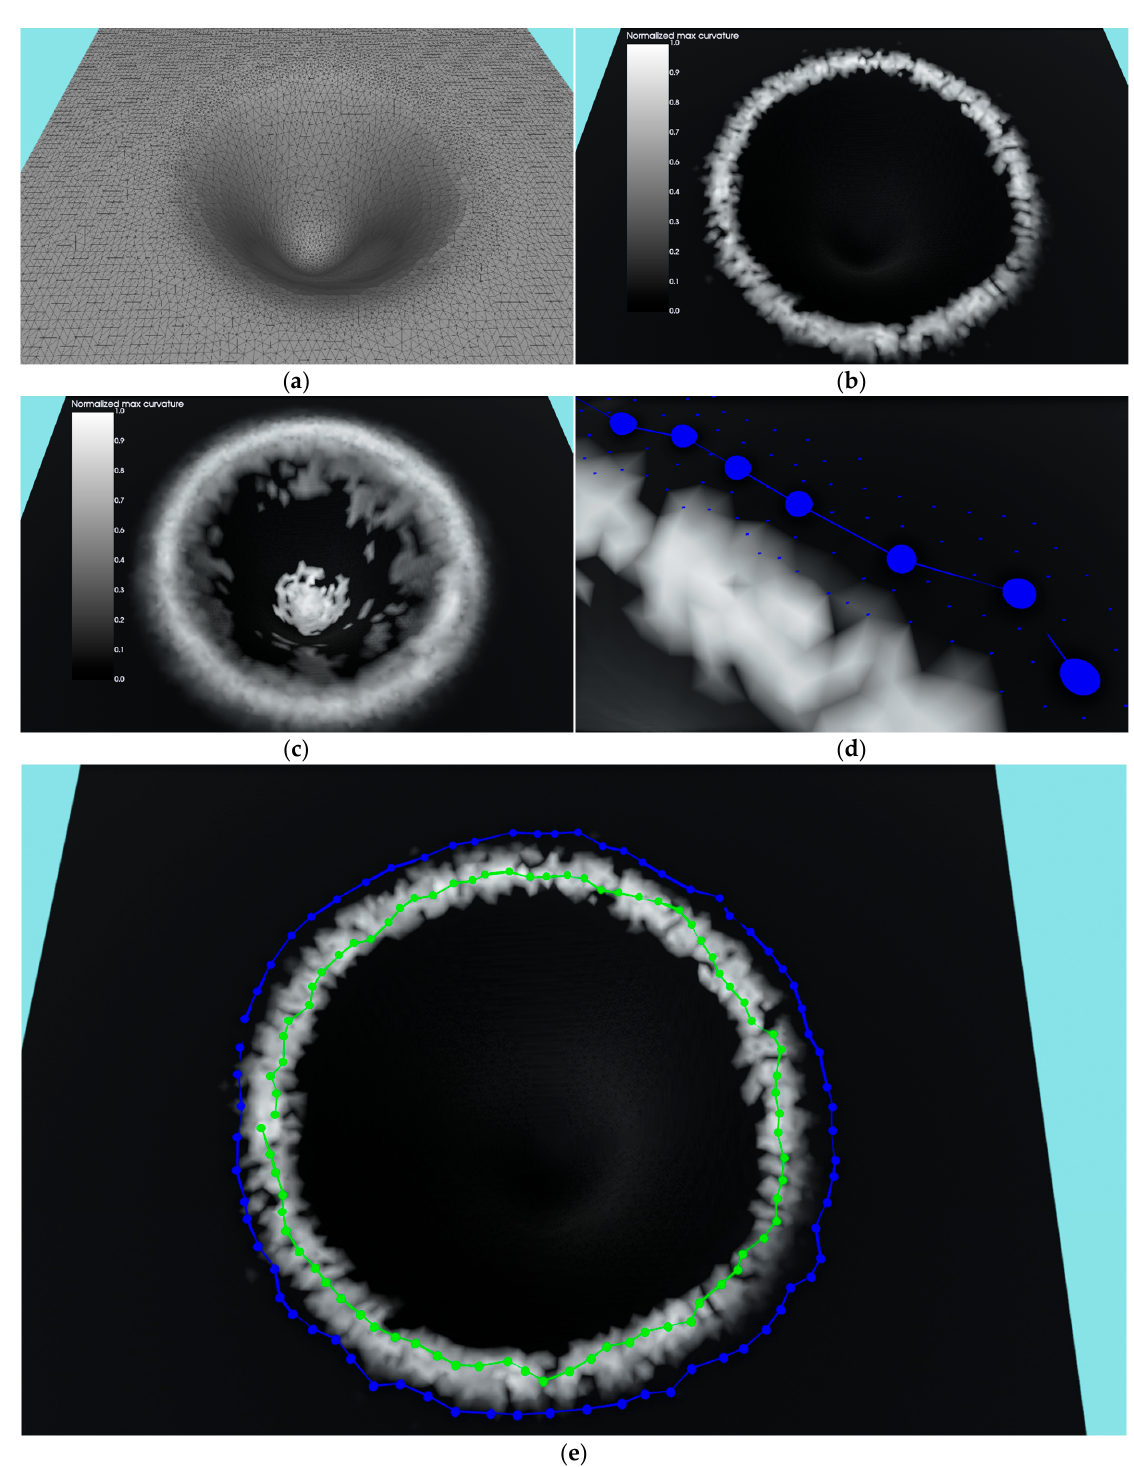
Figure 13. Synthetic example of ACM application: ( a ) input mesh of a hole created in a program; ( b ) curvature texture when using smaller neighborhood radius for calculating PCA; ( c ) curvature texture when using larger neighborhood radius for calculating PCA; ( d ) initial contour with nodes and their two-node neighborhoods; ( e ) initial and fi nal contour (after ACM) with nodes colored in blue and green, respectively.